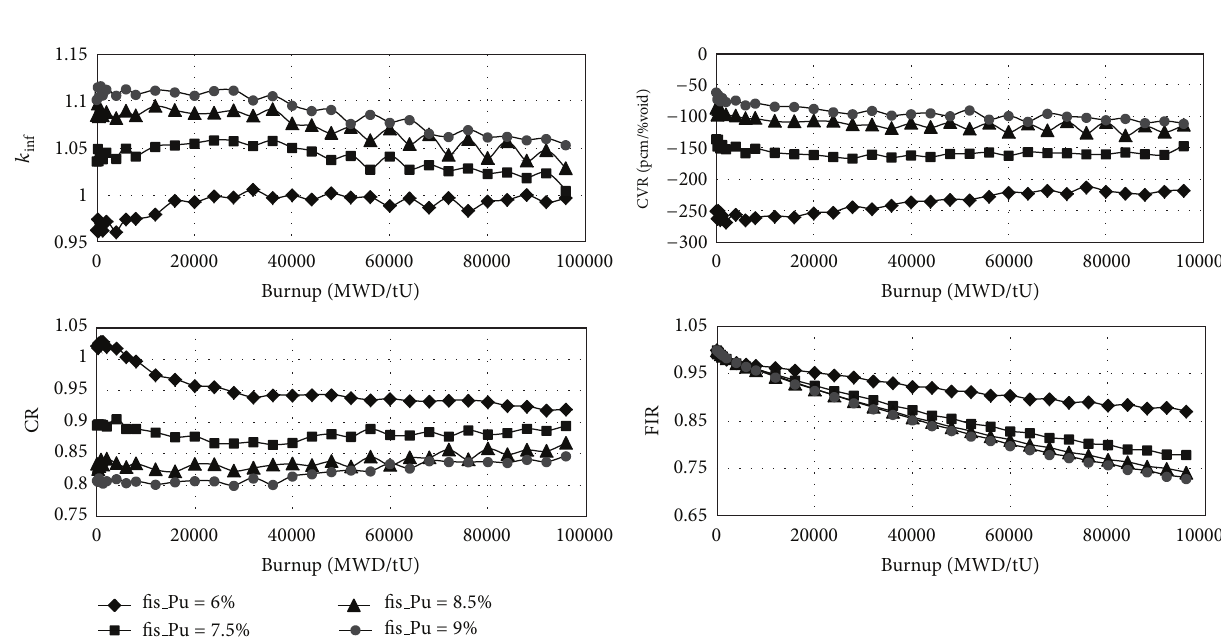
Figure 9: Outer cell burnup performances with Th-MOX